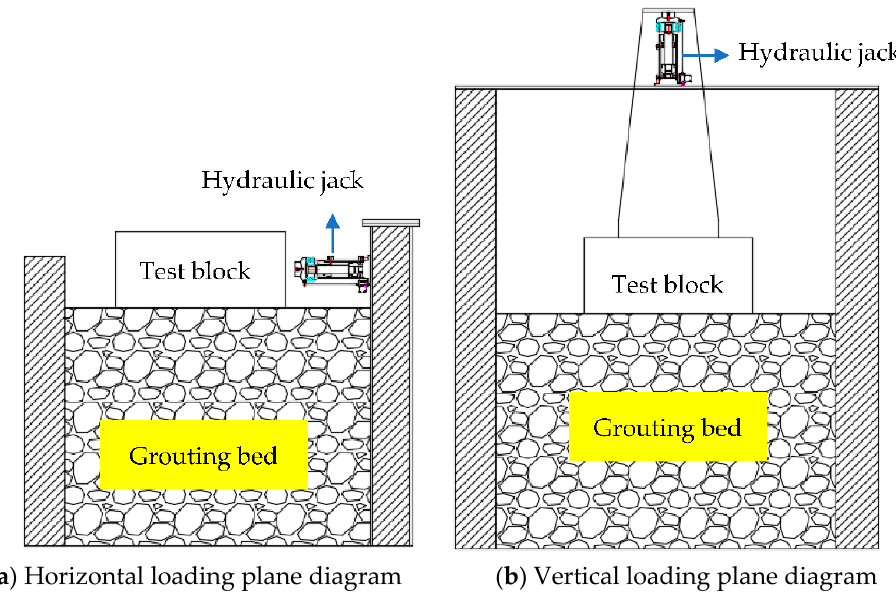
Figure 5. Schematic diagram of the distribution position of the grouting bed, concrete test block, and loading system.